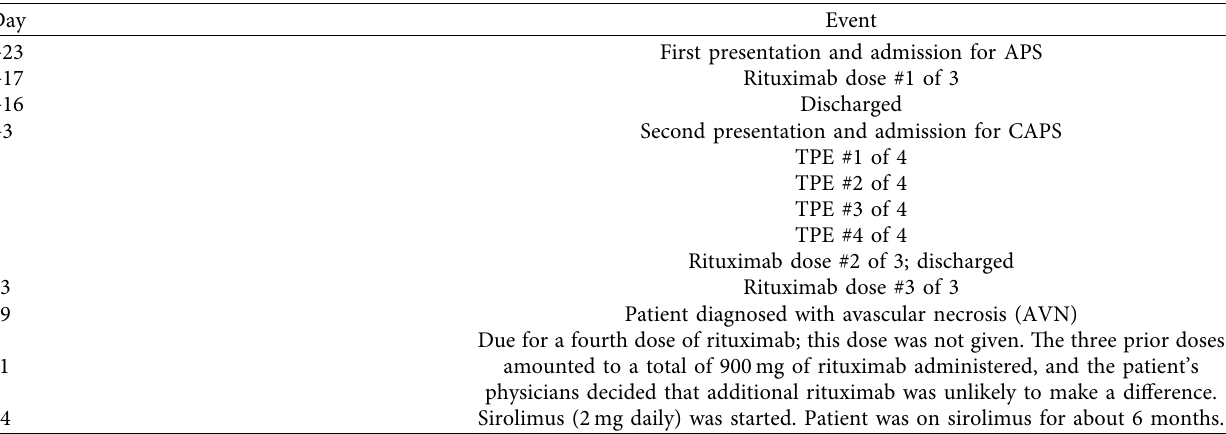
Table 1: Timeline of major